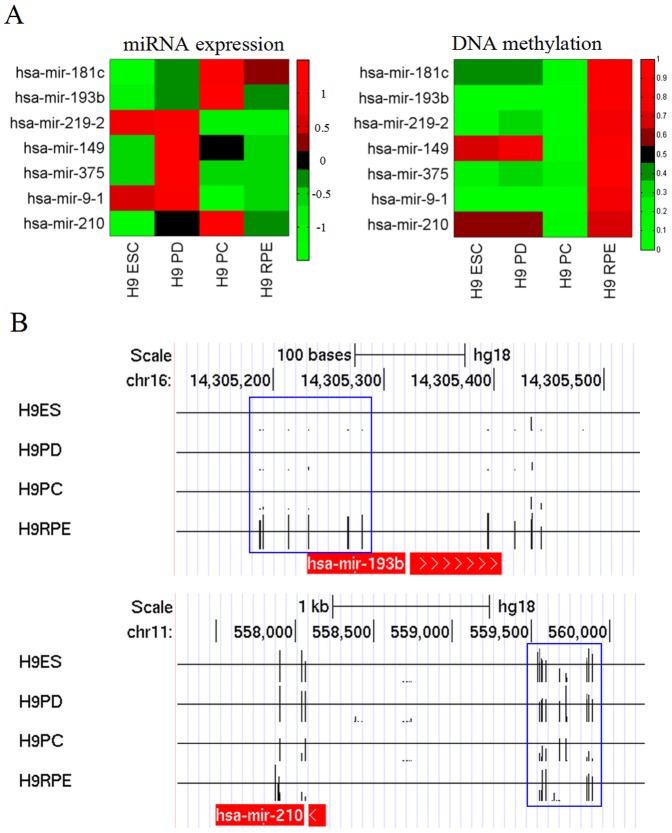
DNA methylation and miRNA expression changes during RPE differentiation.(A) Heatmap analysis of differentially expressed miRNAs during the course of differentiating H9 ESCs. miRNA expression levels were standardized by the mean level in all stages, whereas DNA methylation levels not standardized. DNA methylation values were the average levels between −1000 bp upstream and +500 bp downstream of the TSS. (B) Genome browser views of DNA methylation patterns found in hsa-mir-193b and hsa-mir-210 loci during the course of RPE differentiation.